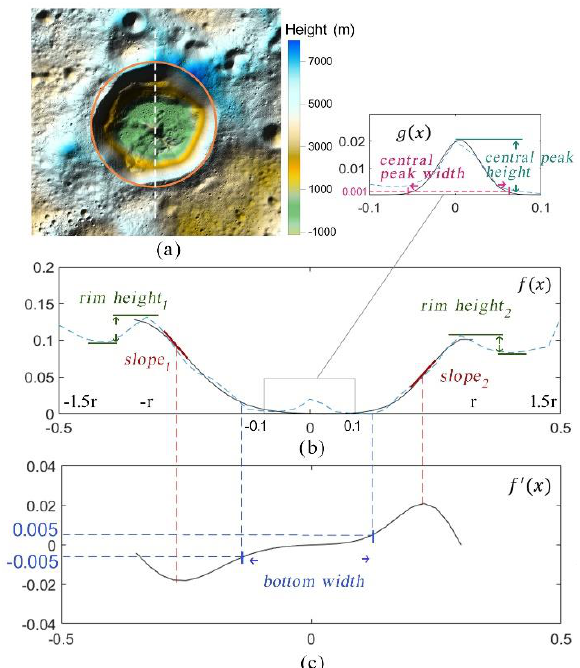
Figure 2. Extraction of 3D morphological information of craters based on Gaussian fitting. (a) The circle shows the boundary of the detected crater, and the dashed line illustrates where the crater profile is extracted. (b) The light-blue dashed line displays the extracted profile, and the black line shows the fitted two-term Gaussian function. For the sake of fitting, the horizontal distance (x-axis) is normalised, and the elevation (y-axis) is enlarged accordingly. The enlarged part on the left shows the central peak fitted by the one-term Gaussian function. (c) The black line is the first-order derivative of the fitted Gaussian function, used for the calculation of morphological